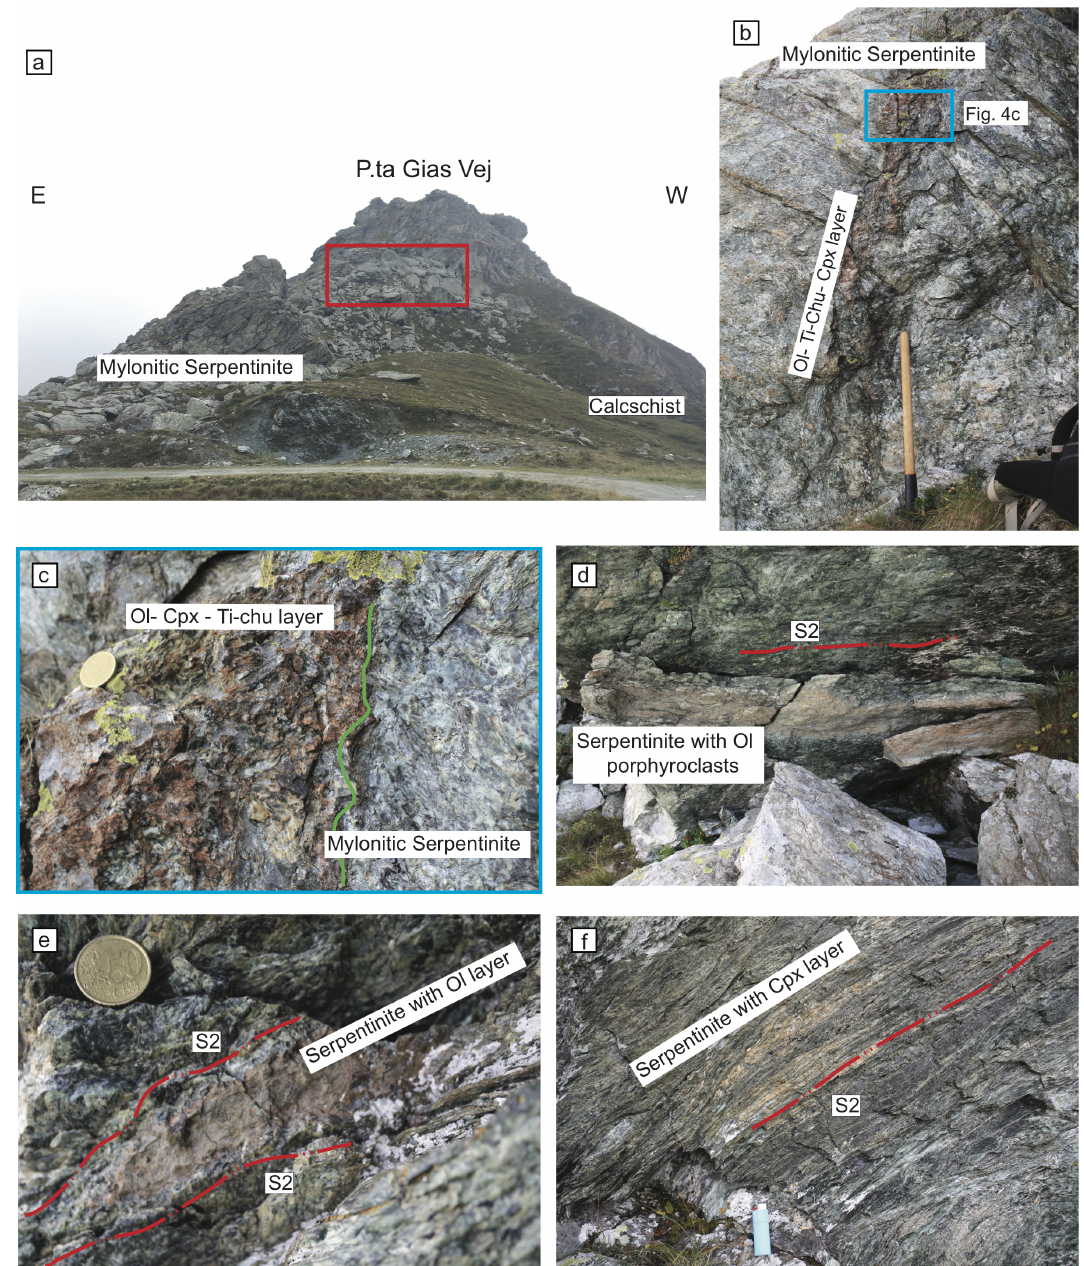
Figure 5. ( a ) Panoramic view of the north slope of Punta Gias Vej with mylonitic serpentinite overlying calcschists. The red rectangle locate the outcrops showed in b, c, d, e and f. ( b–c ) Ol-Cpx-Ti-Chu layer crenulated by D2 folds in the mylonitic serpentinite. ( d ) Serpentinite with Ol porphyroclasts layer re-oriented parallel to S2 foliation in the mylonitic serpentinite. ( e ) Serpentinite with Ol layer wrapped by S2 foliation. ( f ) Serpentinite with fine-grained Cpx layer transposed along